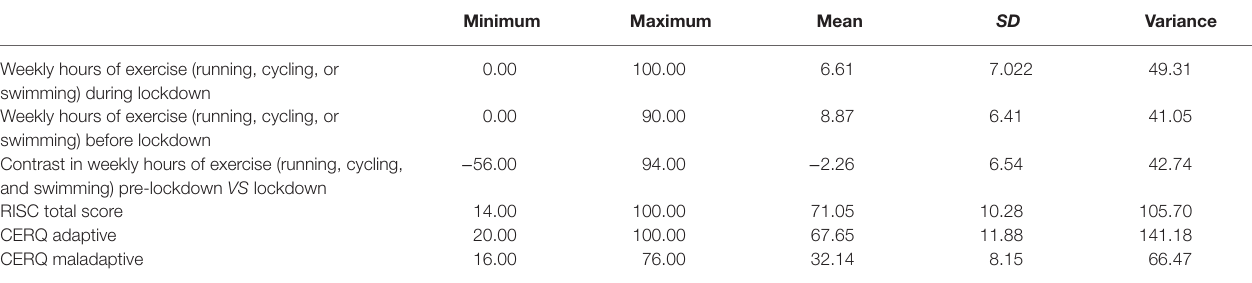
TABLE 1 | Descriptive statistics of the sample.